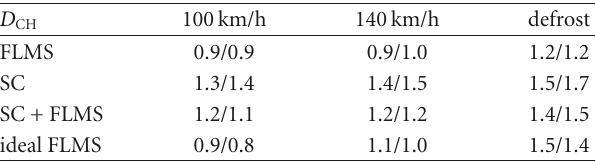
Figure 9: Output SNR values for the combined approach without additional noise suppression (car speed of 100 km/h, ρ = 0).